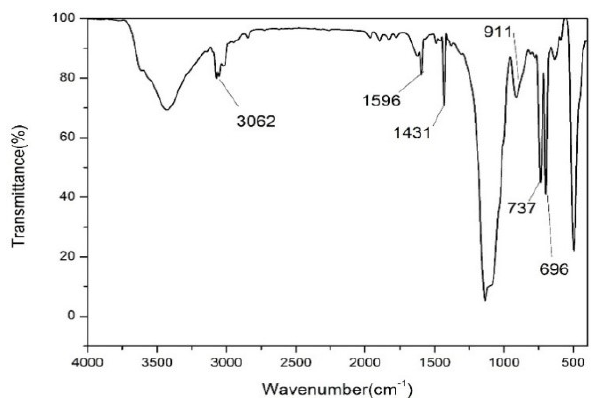
Figure 4: FTIR spectra of heptamertic phenyl silsesquioxane trisilanol(POSS-triol)